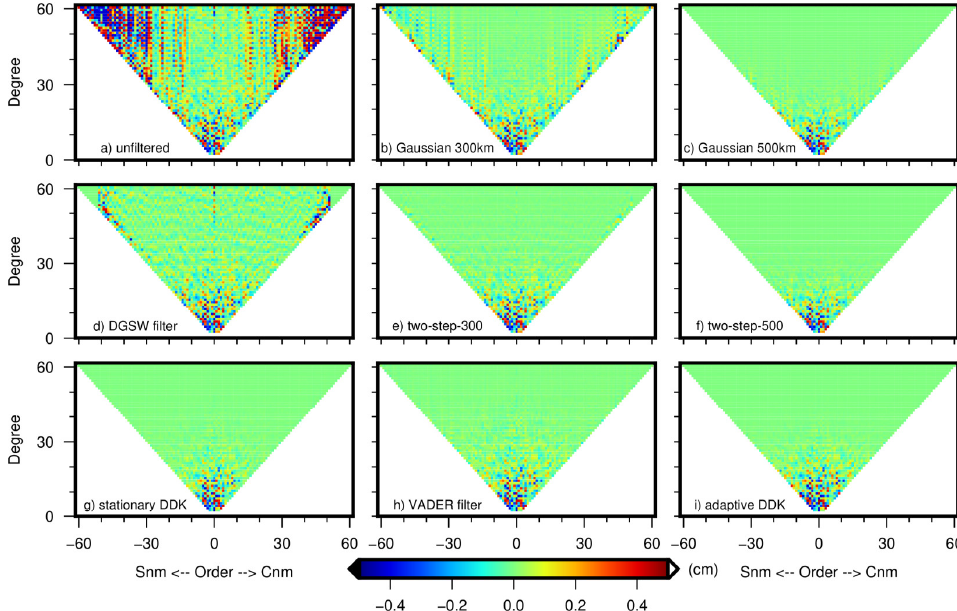
Figure 8. The unfiltered and filtered solutions in the SH domain for September 2006.